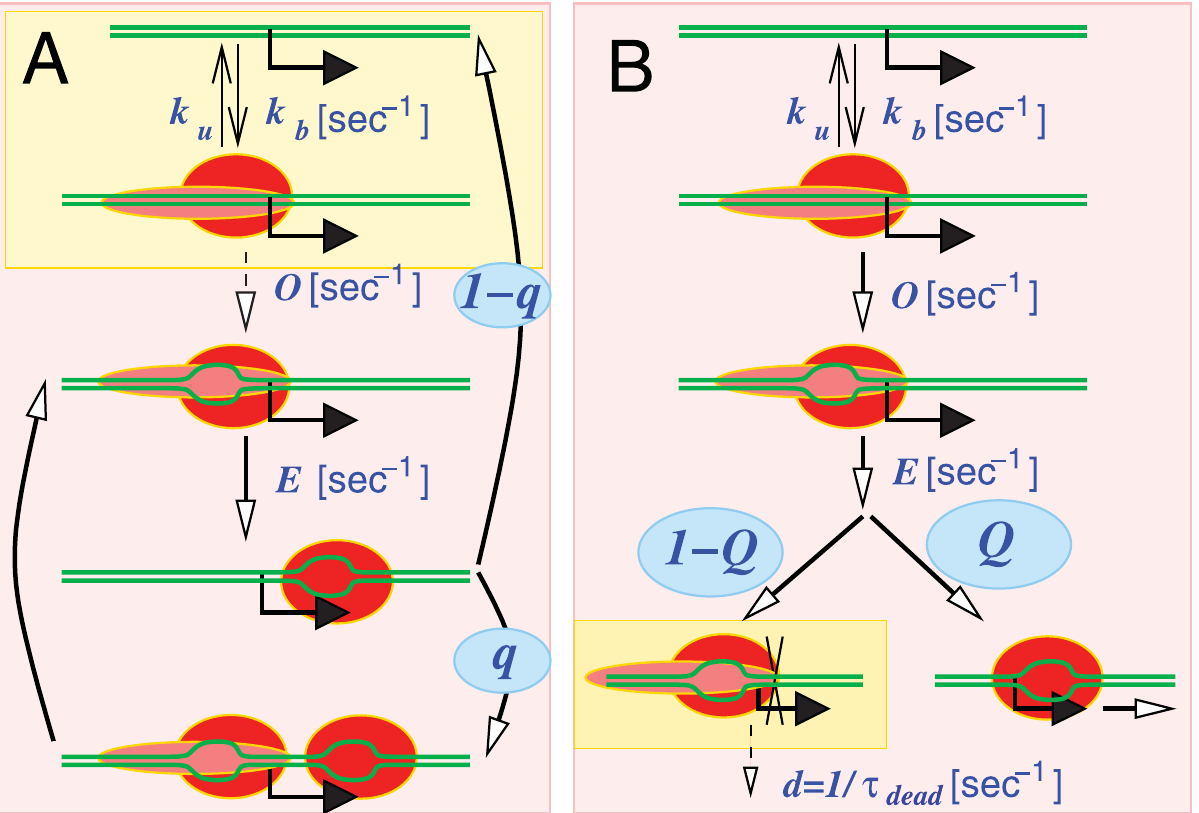
Figure 2. Revisiting mechanisms for bunched firing. We propose (A) supercoiling assisted open complex formation, and (B) possible stalling of an RNAP into a ‘‘moribund’’ complex. The yellow background indicates the state where most of the time is spent in the off period. (A) An elongating RNAP might recruit a subsequent RNAP into an open complex with probability q , thus by-passing the time needed to recruit an RNAP and form open complex. In the limit of large k b , the firing rate is given by F ~ productive and the other is a dead end complex that is removed with rate d . In this case Q denotes the probability that a closed complex enters into the productive open complex. In the limit of large k b , the firing rate is given by F